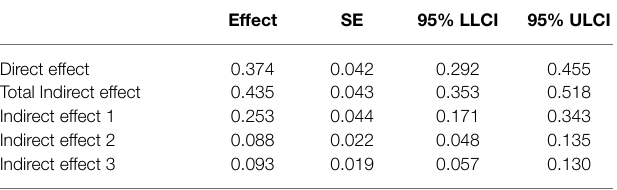
TABLE 5 | Mediation effect with bootstrapping.